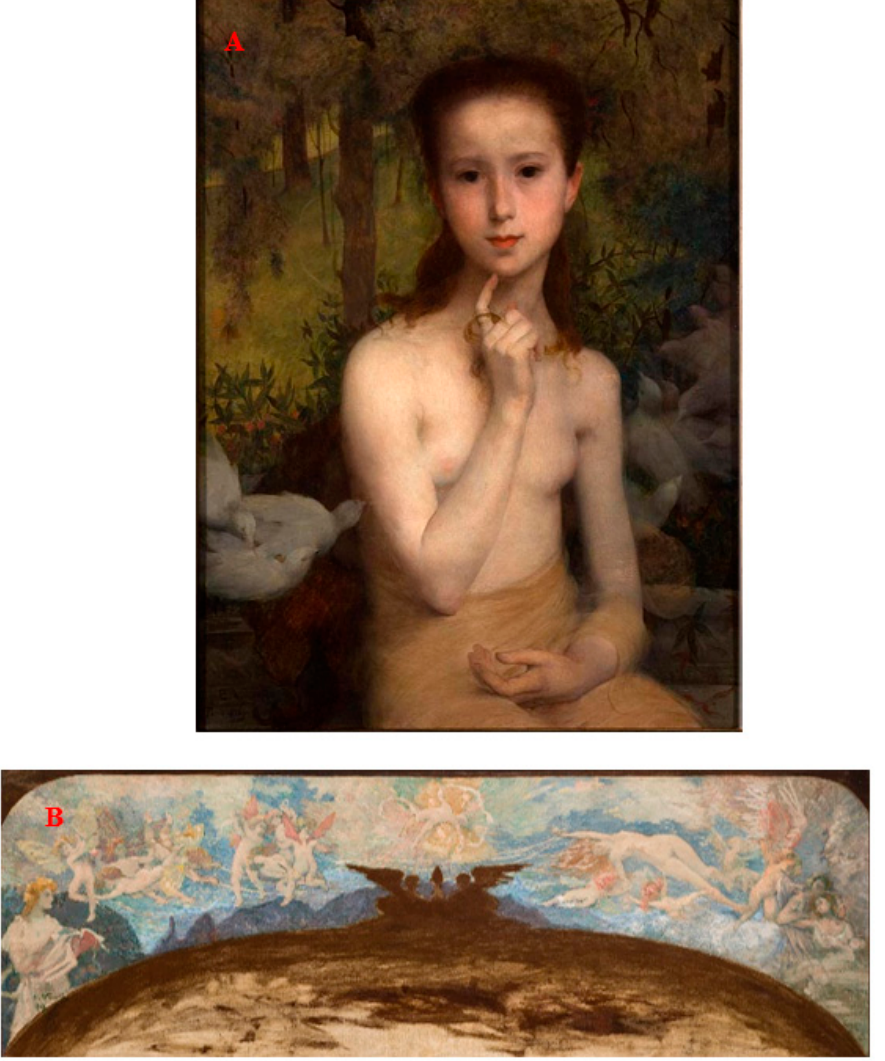
Figure 4. Eliseu Visconti, “ Gioventú ”, 1898, dimensions (65 cm × 49 cm), National Museum of Fine Arts/collection, Rio de Janeiro ( A ); Eliseu Visconti, “ A poesia e o amor afastando a virtude do vício ”, 1908, dimensions (170 cm × 85 cm), Municipal Theater Foundation/collection, Rio de Janeiro ( B ).